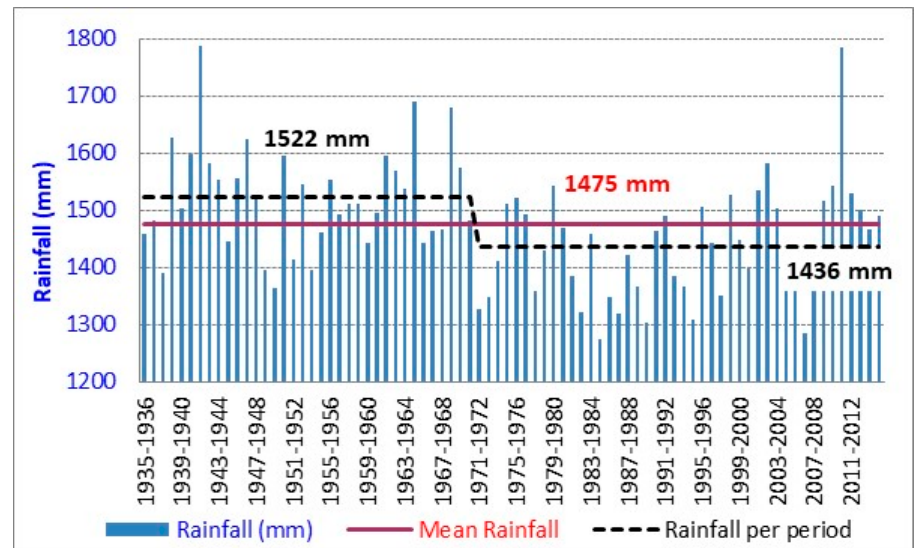
Figure 5. Discontinuities in the annual rainfall series for Ubangi basin, which comes from Nguimalet & Orange (2019) [3].